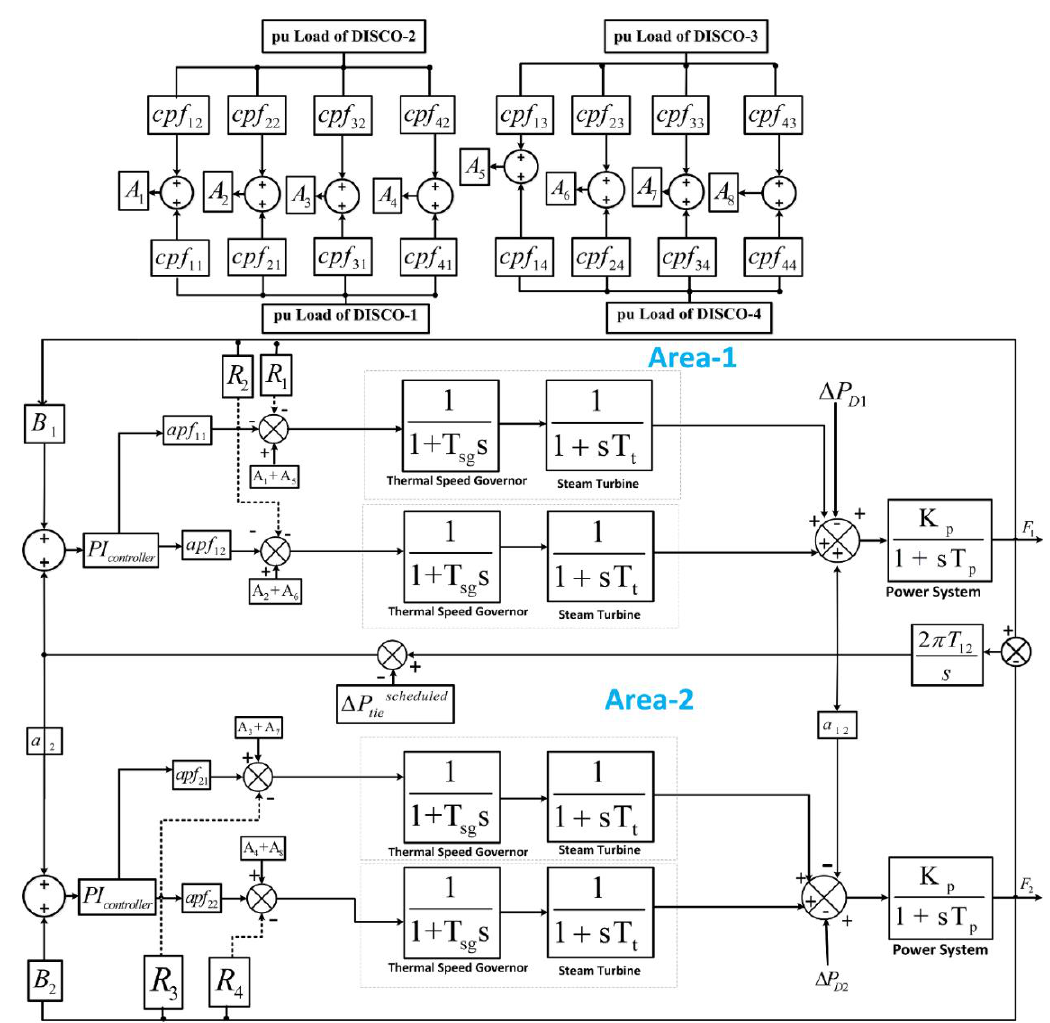
Figure 2. Transfer function model.